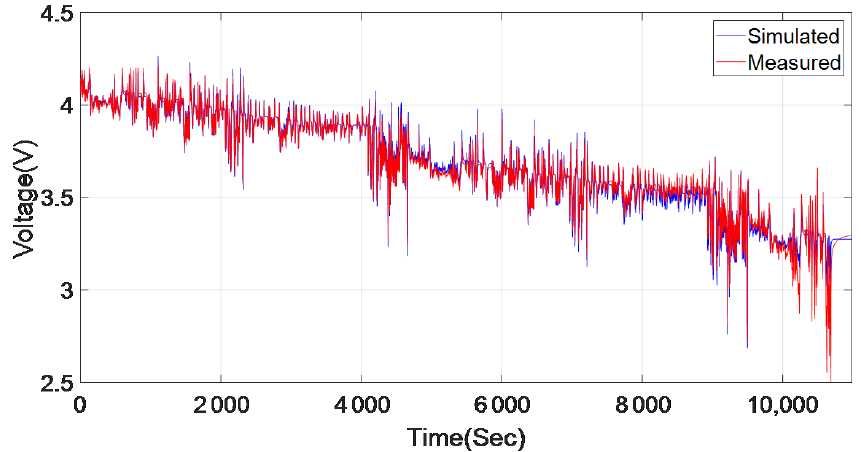
Figure 6. Measured and simulated model output.